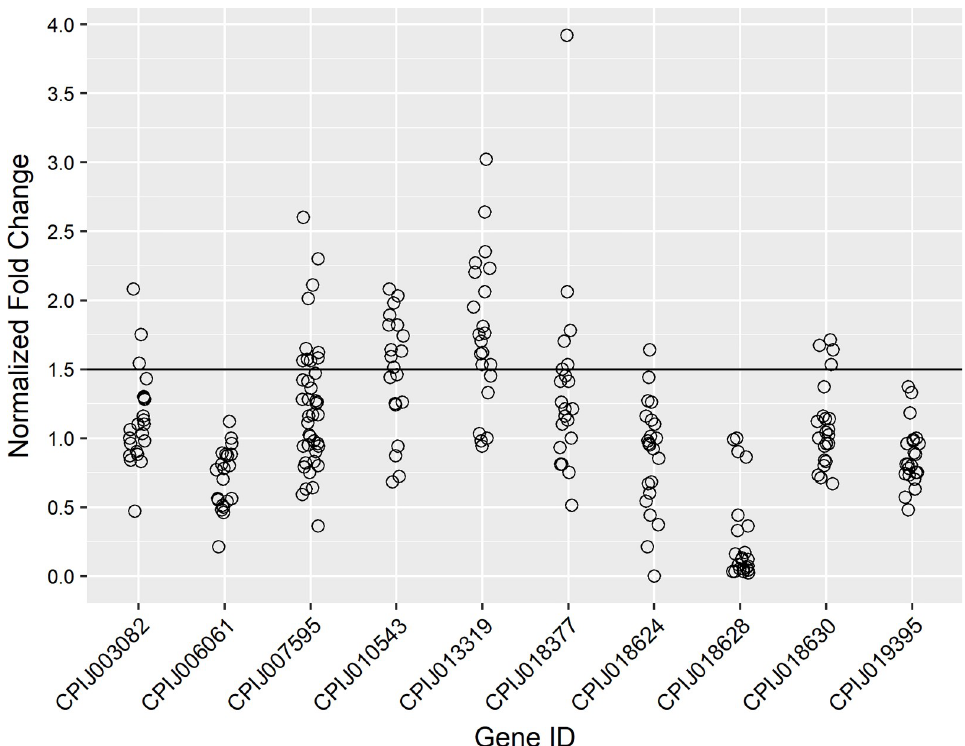
Fig 2. Chart showing CNV (copy number variation) validation results with gDNA as normalized fold changes of candidate genes in phenotypically resistant individuals. Each open circle represents one individual mosquito. Fold- changes � 1.5 were taken as evidence of increased copy